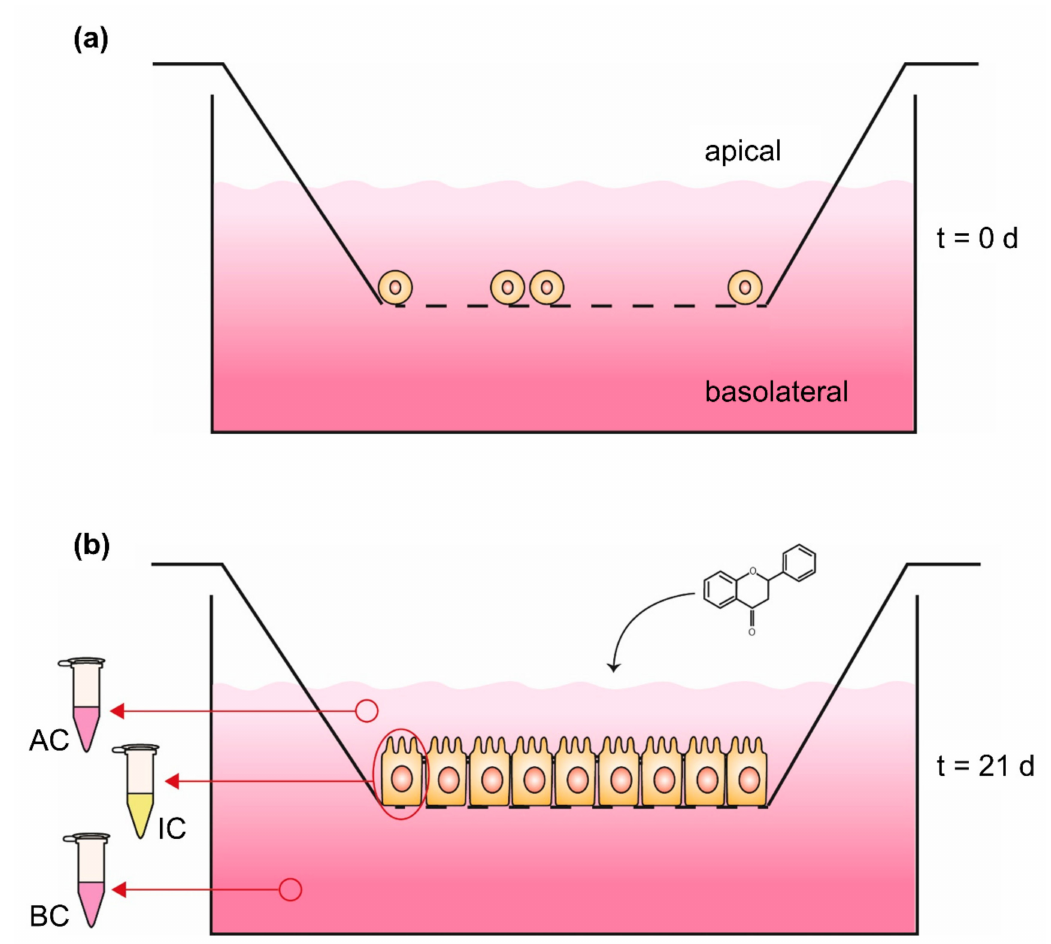
Figure 3. Caco-2 monolayer transport system ( a ) at seeding time (t = 0 days) and ( b ) 21 days (t = 21